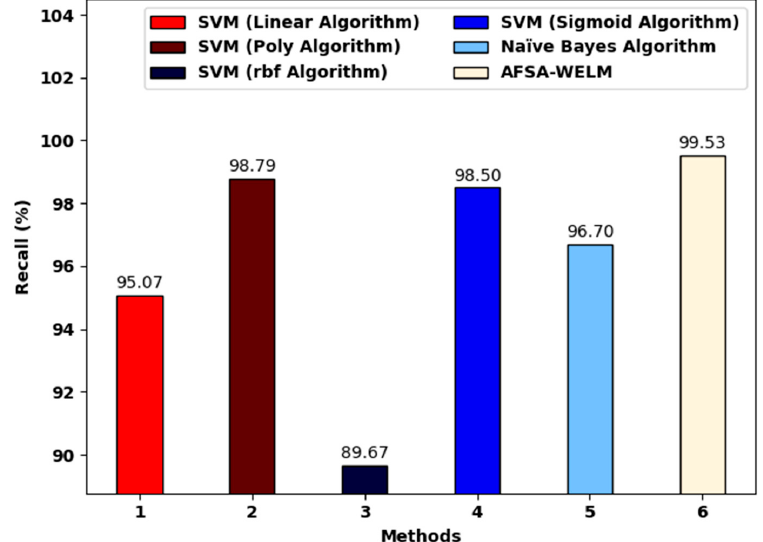
Figure 8. The Reca l analysis of the proposed model and existing Figure 8. The 𝑅𝑒𝑐𝑎 (cid:3039) analysis of the proposed model and existing algorithms.